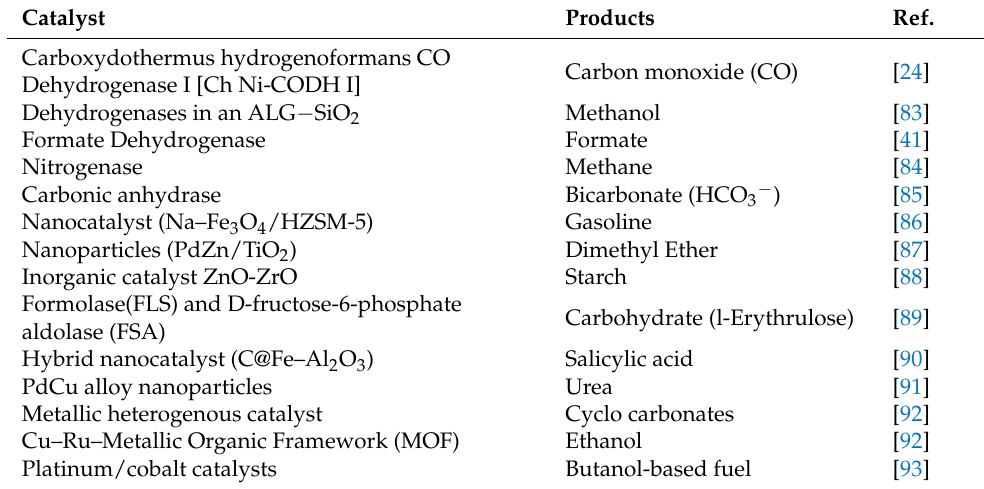
Table 2. List of products formed via chemo-enzymatic approach of CO 2